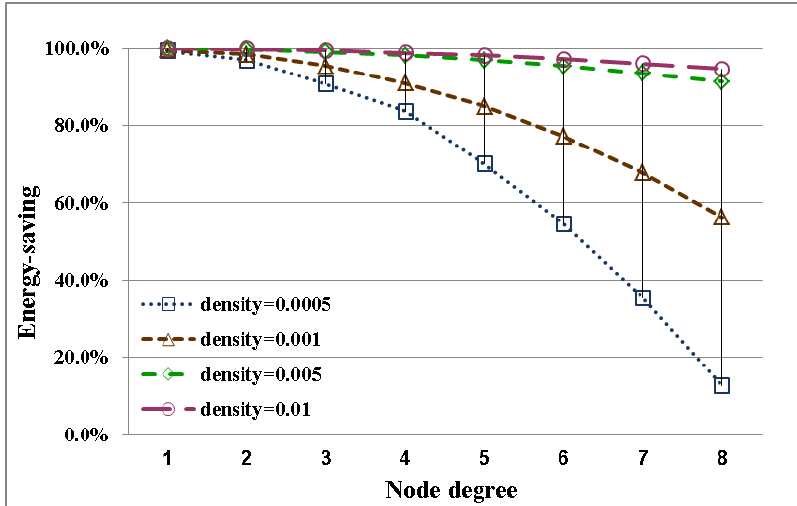
Figure 10. A comparison of simulation results for energy savings with node degrees ranging from 1 to 8 with different node